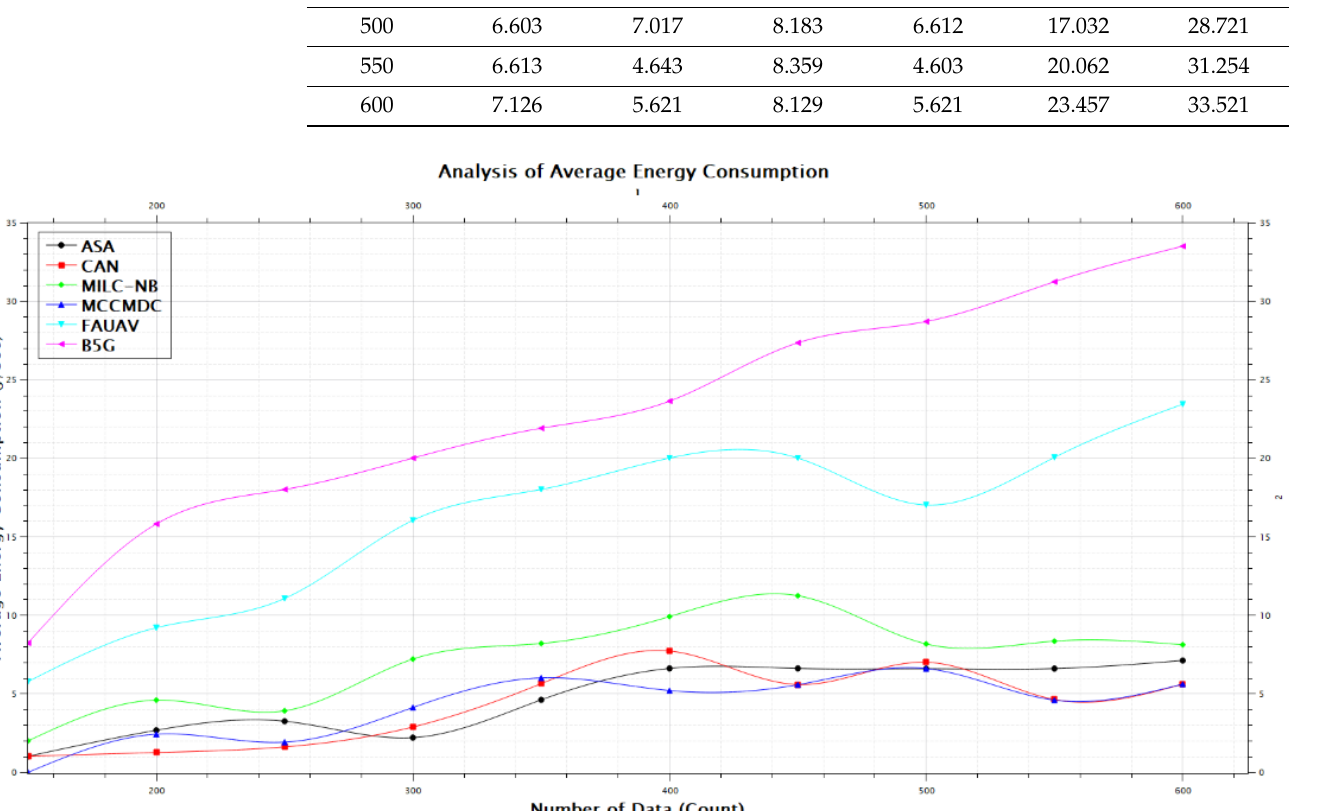
Figure 7. The power energy consumption after data obfuscation.